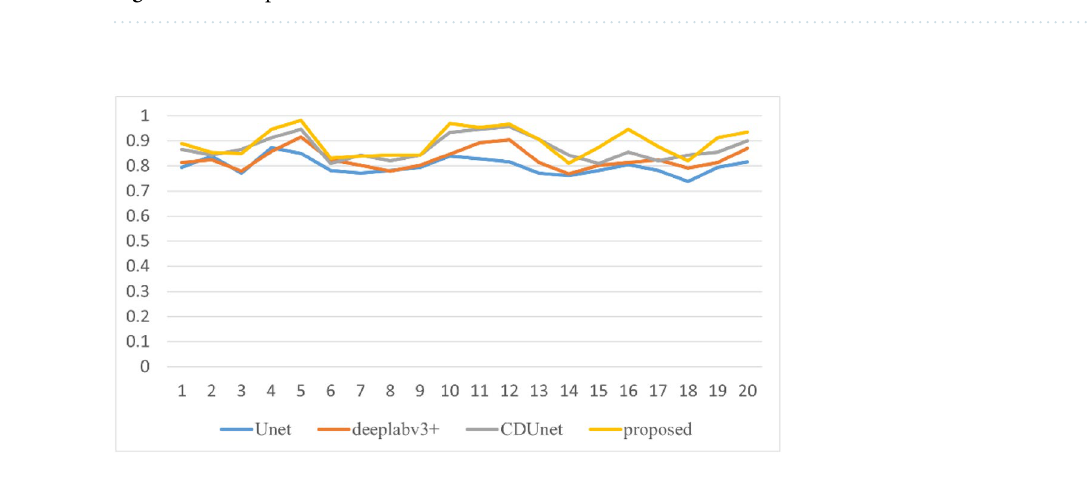
Figure 12. Comparison of mPA values of different